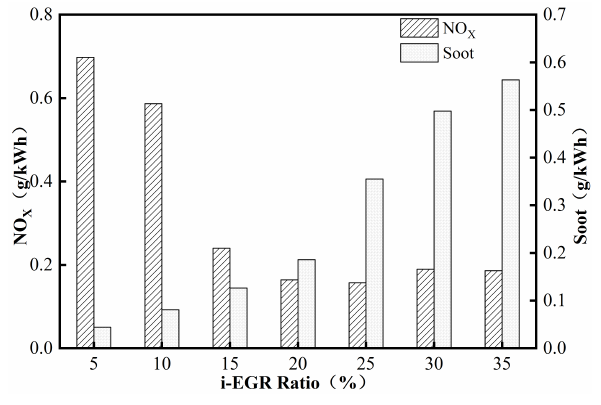
Fig. 16 Effect of i-EGR and e-EGR ratios on NO X and soot emission.